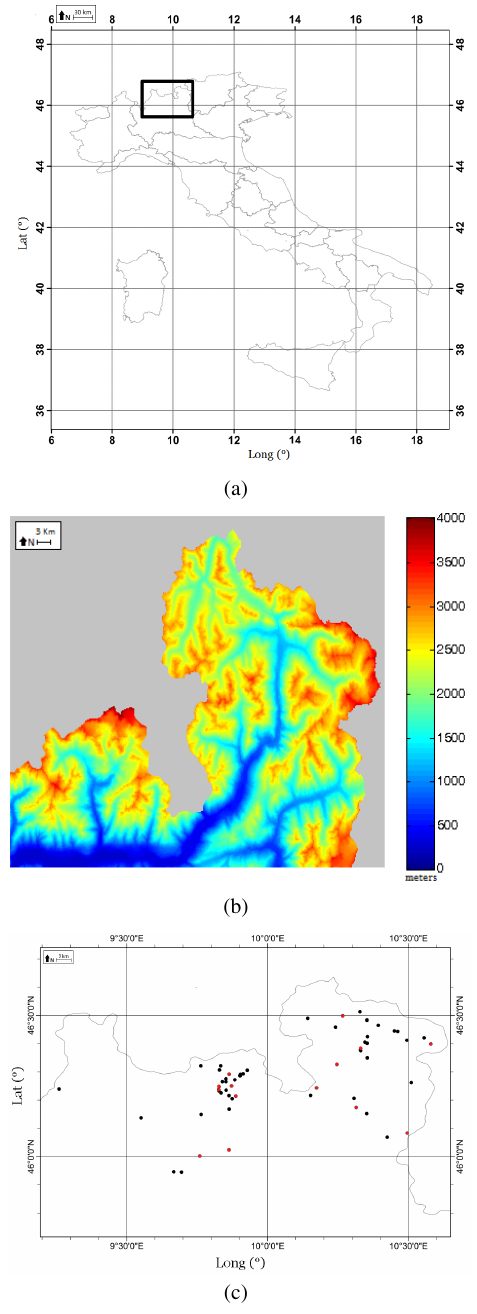
Fig. 1. (a) The study region enclosed in a black rectangle with lat- itudes (y axes) and longitudes (x axes) expressed. (b) The Digital Elevation Model, related to the study area indicated in (a). The lo- cations of all stations of the initial data set equipped with different types of sensors are marked in figure (c). The locations of the 14 stations equipped with air temperature sensor, snow thickness sen- sor and precipitation gauge, used for the final data set are colored in red.